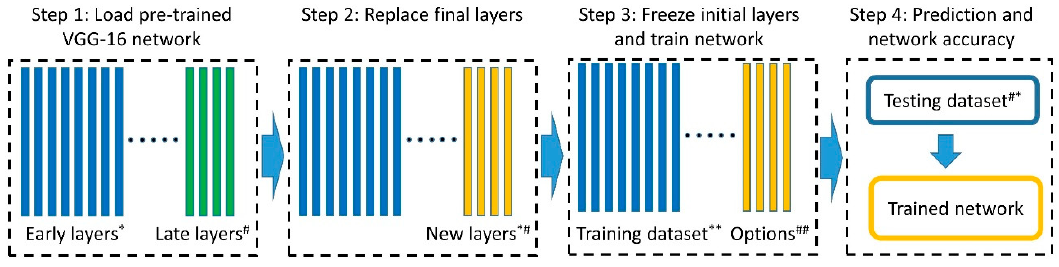
Figure 11. Procedure of updating VGG-16 for lodging detection. * Early layers learn low-level features (e.g., edges and colors); # late layers learn task-specific features; *# new layers learn features related to lodging; ** training dataset are 260 randomly selected plots (70%) of the entire dataset; ## options set for training (e.g., data augmenter and epochs); #* testing dataset is the other part (112 plot images) of the entire dataset.